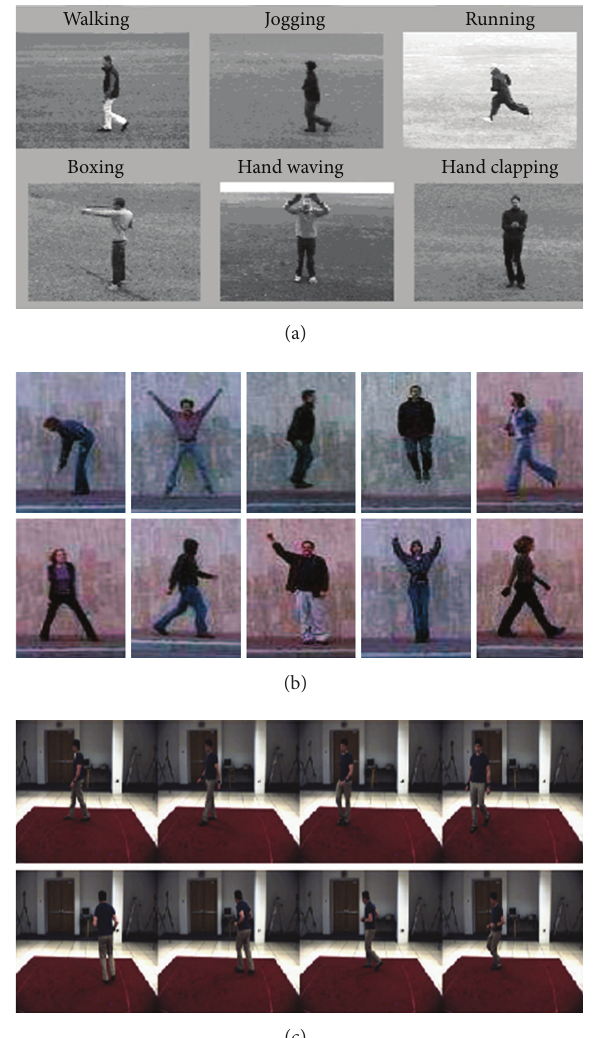
Figure 4: Sample frames from our datasets. The action labels